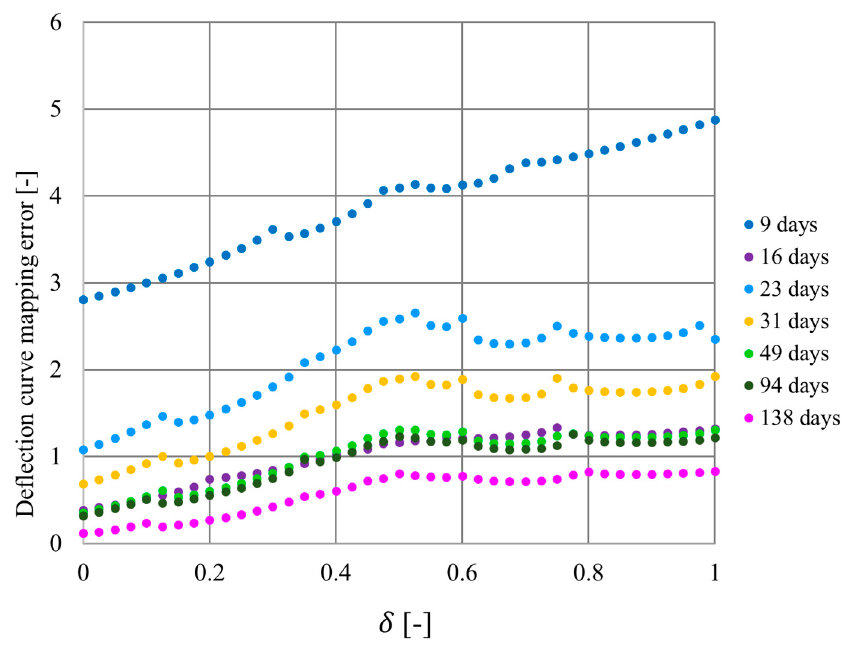
δ (Section 3R). Figure 14. Deflection curve mapping error as a function of parameter δ (Section